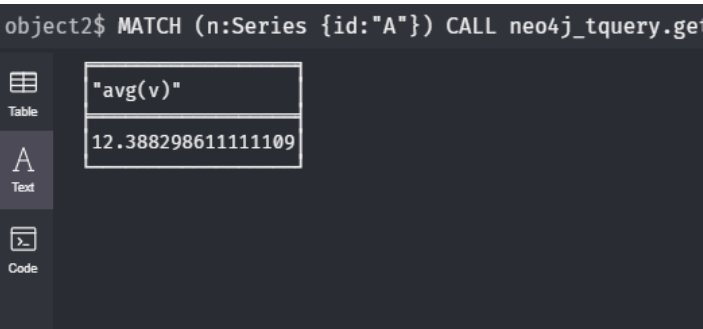
Figure 7. Visualization of the output of query Q 3 run on the sensor network of Figure 4. The result is taken from the web interface of Neo4j.